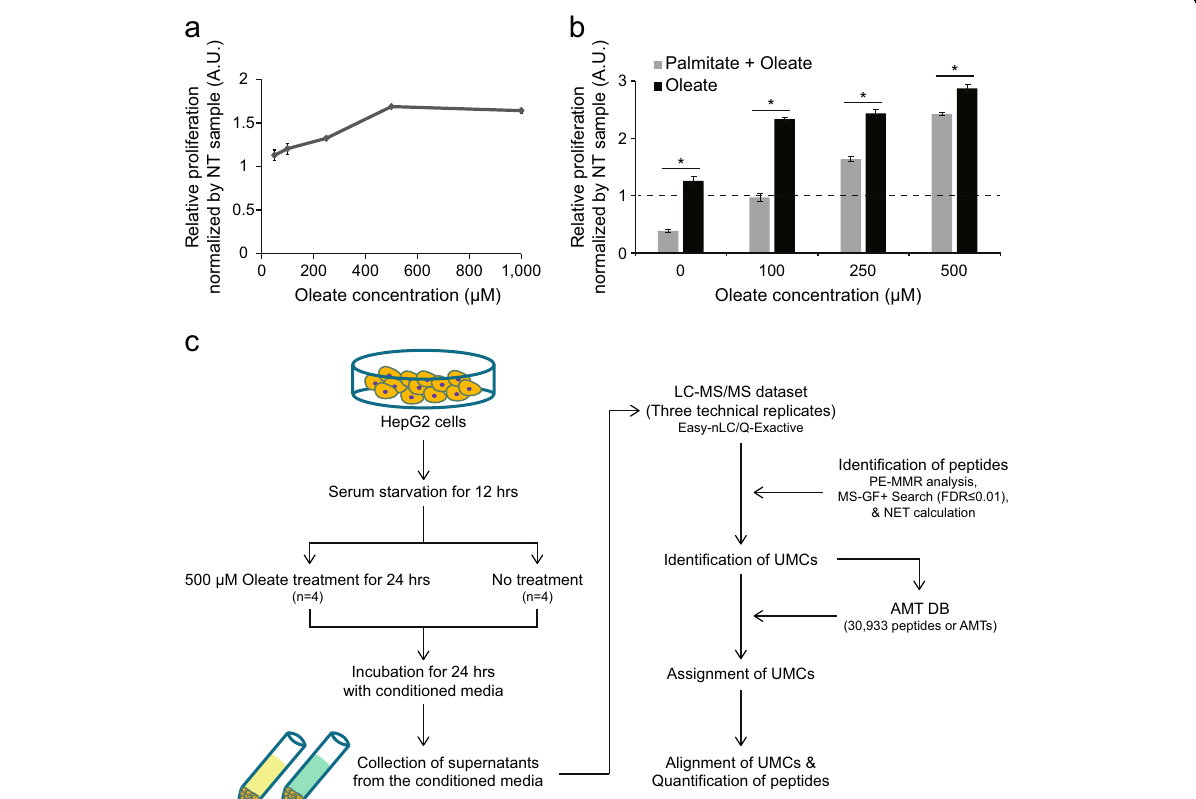
Fig. 1 Cell proliferation assay and secretome pro fi ling of oleate-treated and untreated HepG2 cells. a , b MTT assays for measuring proliferation of HepG2 cells after treatment with different concentrations (50, 100, 250, 500, and 1000 μ M) of oleate ( a ) and after cotreatment with palmitate (500 μ M) and oleate (0, 100, 250, or 500 μ M) ( b ). The data are shown as the mean ± SEM ( n = 4). * P < 0.05 by Student ’ s t -test. The dashed line denotes the threshold of relative proliferation = 1. c An overall scheme for the secretome pro fi ling. HepG2 cells were subjected to serum starvation for 12 h and then treated with oleate (500 μ M). Oleate-treated ( n = 4) and untreated ( n = 4) samples were incubated for 24 h with conditioned media, and supernatants from the conditioned media were collected for sample preparation. LC-MS/MS analyses were performed for Peptide samples from oleate-treated and untreated samples with three technical replicates. The resulting LC-MS/MS datasets were analyzed using PE-MMR analysis, MS-GF + search, and AMT DB analysis for identi fi cation, assignment, and alignment of UMCs (see